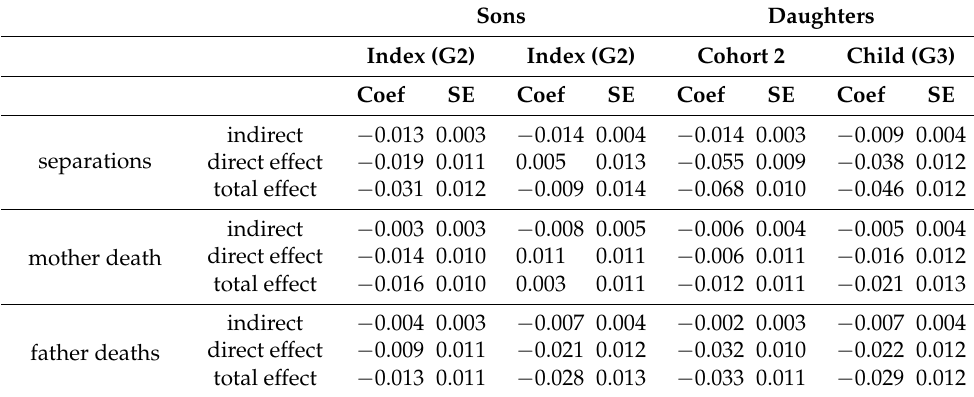
Figure 5. Standardized Direct and Indirect effects of parental absences on age at first birth for ( a ) sons and ( b ) daughters, by generation. Effects are relative to having married and cohabiting parents. University attendance is a mediator. Only effects with solid outlines have bootstrapped percentile 95% confidence intervals that did not include zero. NB: the directions of effects deviate from the Figure 4 schema in that for sons in the child generation (G3) maternal deaths and parental separations have positive direct effects on age at first birth (c is +). Table 3. Standardized effects of mediation analysis by gender, generation, and type of parental absence. Bootstrapped standard errors are